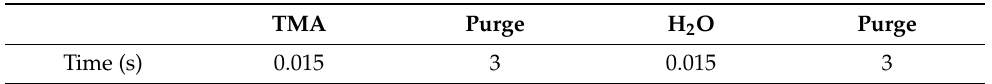
Table 1. ALD cycle used in the work. Deposition chamber is flushed by 20 SCCM of N 2 . (SCCM: standard cubic centimeters per